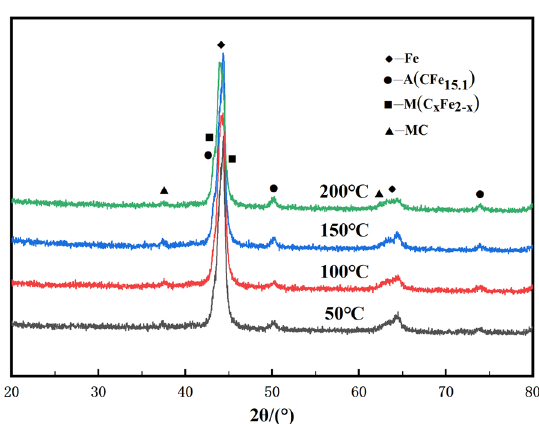
Figure 10 XRD patterns of HSS samples at different substrate